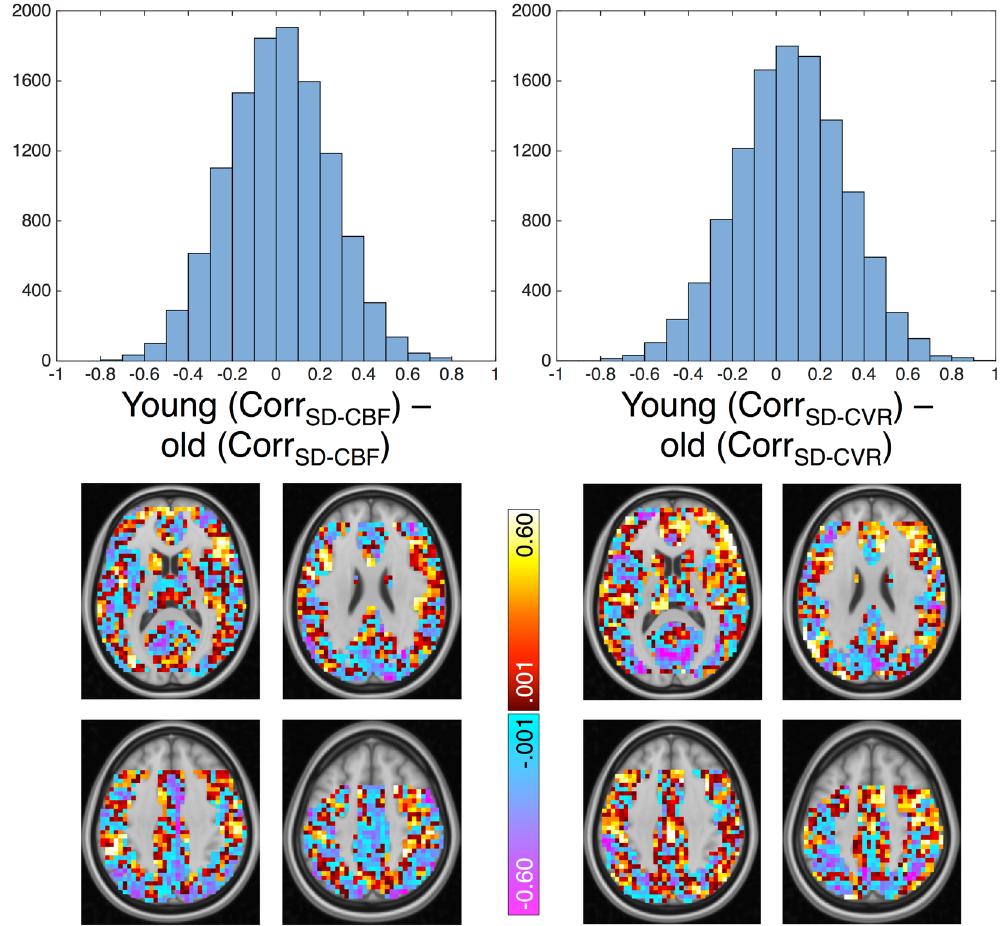
Figure 4. Differential voxel-wise coupling strength between SD BOLD , and CBF and CVR in younger and older adults. Note: Correlations between SD BOLD -CBF, and SD BOLD -CVR are computed for each voxel, across age group members. Voxel histograms represent a young minus old group difference of these voxel-wise correlation values (upper row), which are then plotted in the brain maps below each histogram (lower row). Slices for each distribution represent Z = 12 (upper left), 24 (upper right), 36 (lower left), and 48 (lower right). Orientation of images: right is right. Missing data in frontal regions are a result of partial coverage and angulation restrictions for adequate tagging in pCASL data. For complete description of both histrograms and spatial representation, these maps are intentionally